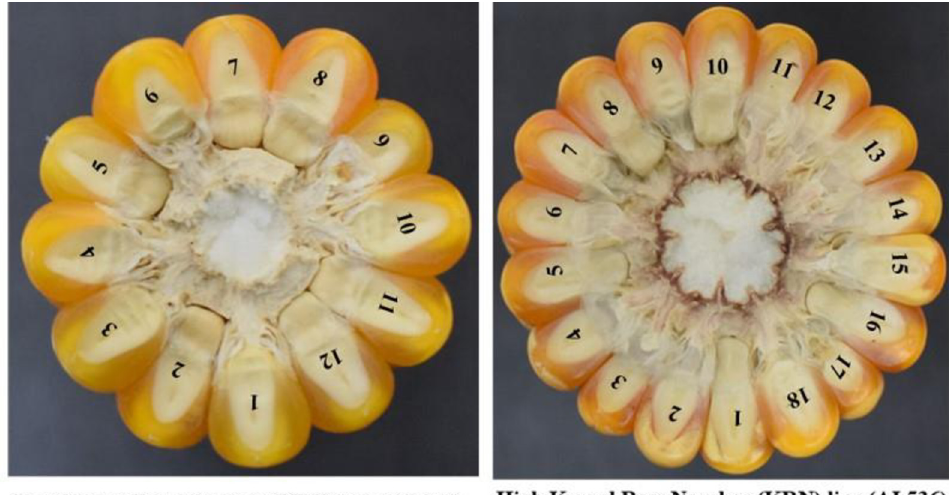
Fig 1. Contrasting parents for high and low KRN trait.